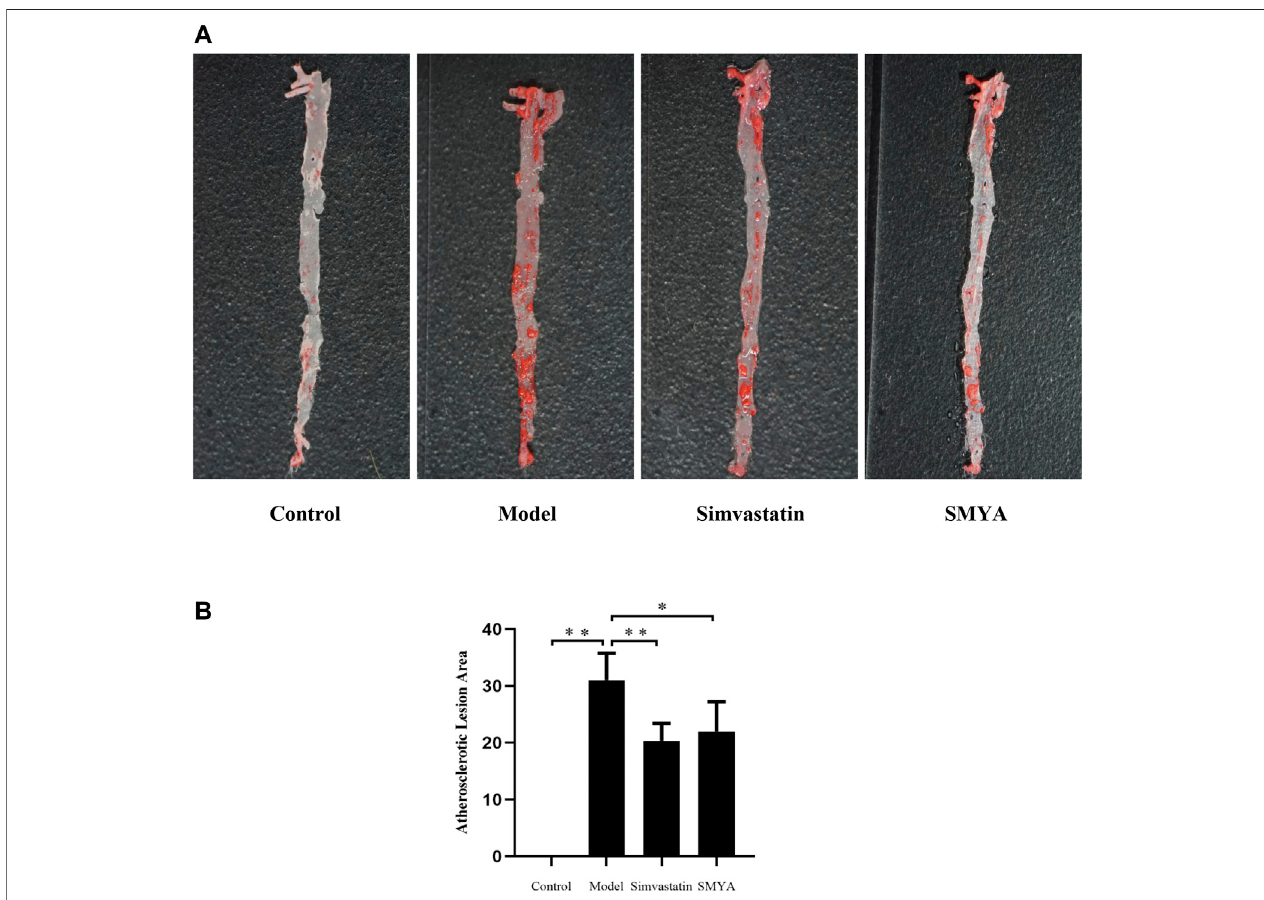
FIGURE 1 | Effect of SMYA on Atherosclerotic Lesion Area. (A) oil red o staining showed: in control group, the aorta was milky white, and the aorta intima was smooth and without lipid deposition. Compared with the control group, large areas of continuous fl aky red atheromatous plaques could be seen, which was mainly concentratedintheaorticarchandtheabdominalaortaandtheplaqueareaofaortaintimawassigni fi cantlyincreasedinmodelgroup.Comparedwiththemodelgroup, only scattered red atherosclerotic plaques could be seen and the plaque area of aorta intima was decreased in both of simvastatin group and SMYA group. (B) quantitative analysis of SMYA on atherosclerotic lesion area. Data are expressed as mean ± SD. *p < 0.05, **p < 0.01.